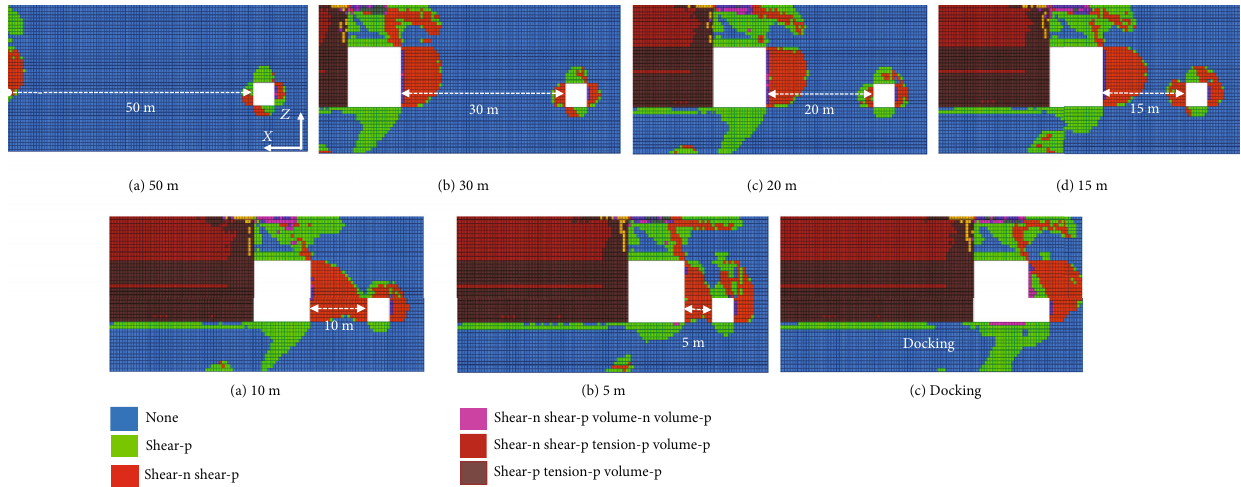
Figure 11: Evolution diagram of plastic zone distribution characteristics of remained coal